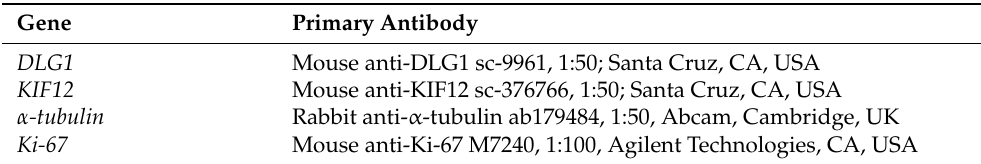
Table 1. Primary antibodies used for Immunohistochemistry. Gene Primary Antibody